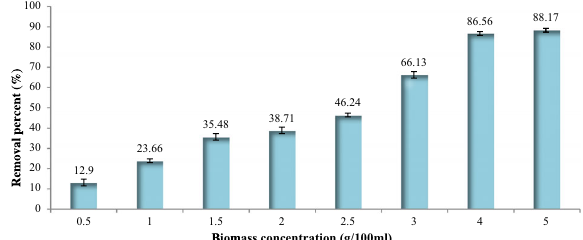
Fig. 1 Effect of variation of the weight of A. niger bioadsorbent on the removal percent of iron III, when using (0.01 M) Fe + 3 as initial solution at the solution pH 2.4 and for a contact time 60 min at room temperature. n = 3 determinations.